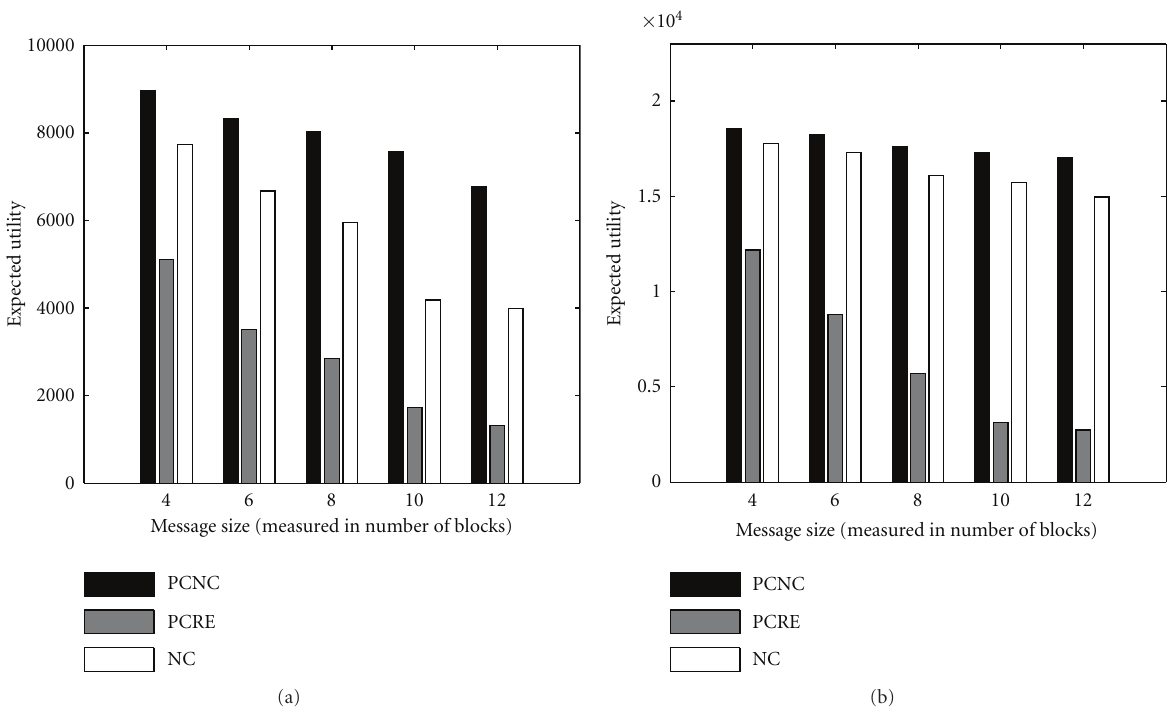
Figure 6: The comparison among three schemes (PCNC, PCRE, and NC) with di ff erent message sizes for multicast routing, when (a) A = 1000 and (b) A =